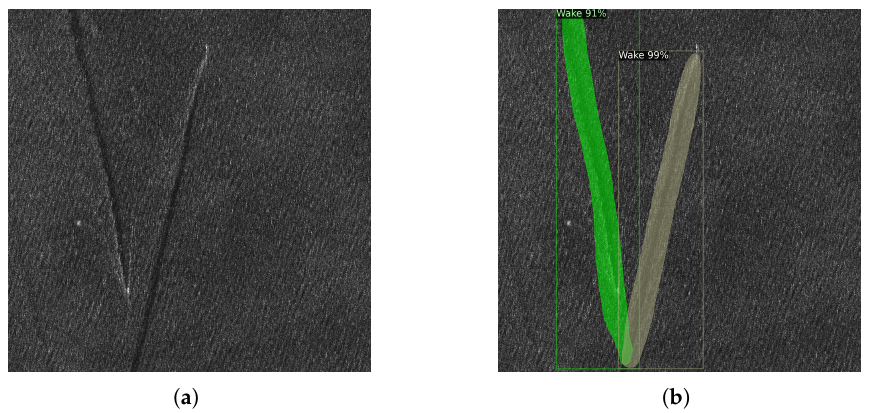
Figure 11. Subset (2000 × 2000 pixels) of the TSX product (TSX1_SAR_SSC_BTX1_SM_D_SRA_ 20110609T164931_20110609T164939) gathered in VV polarization over the Gulf of Naples, Italy on 9 June 2011 (Azimuth-Slant Range coordinates). ( a ) Reference image, ( b ) Segmentation